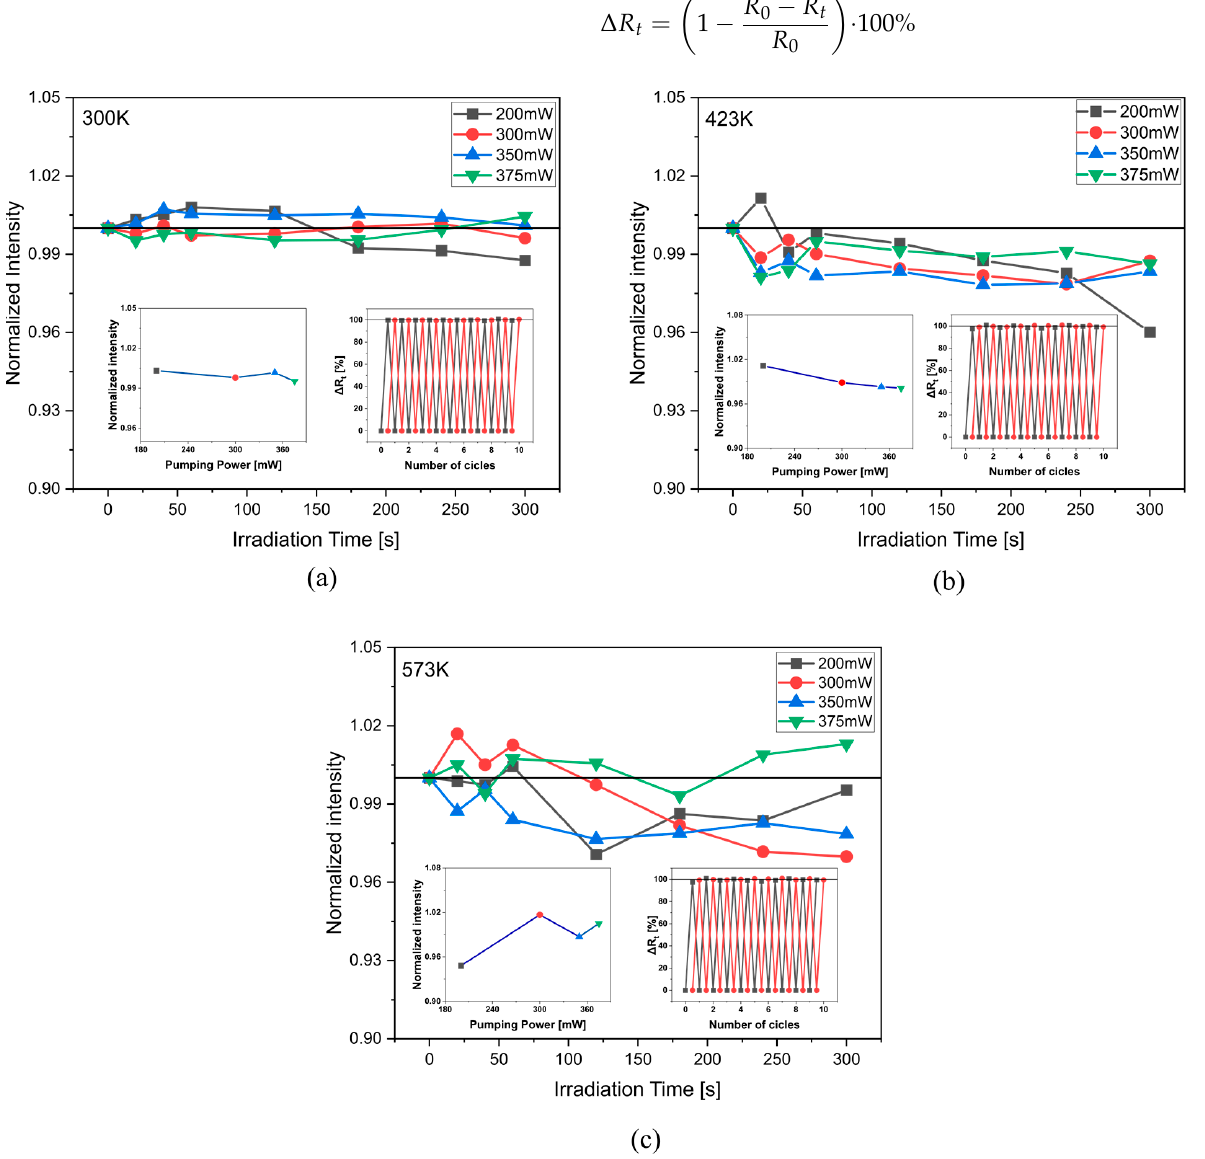
Figure 4. Normalized emission intensity at 545 nm versus irradiation time at ( a ) 300 K; ( b ) 423 K; ( c ) 573 K. The insets on the left show UC emission at 545 nm versus pumping power at 20 s irradiation time. The insets on the right show luminescent switching contrast of 980 nm excitation at 300 mW (black) and 375 mW (red).